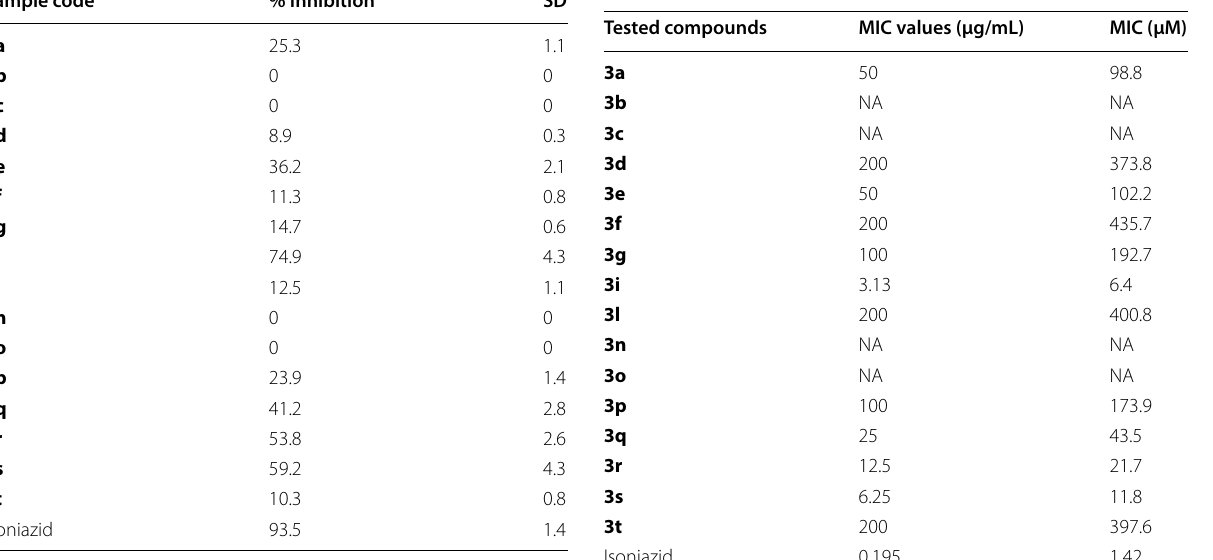
Table 2 The estimated minimum inhibitory concentrations (MICs) of the synthesized compounds against Mycobacte- rium